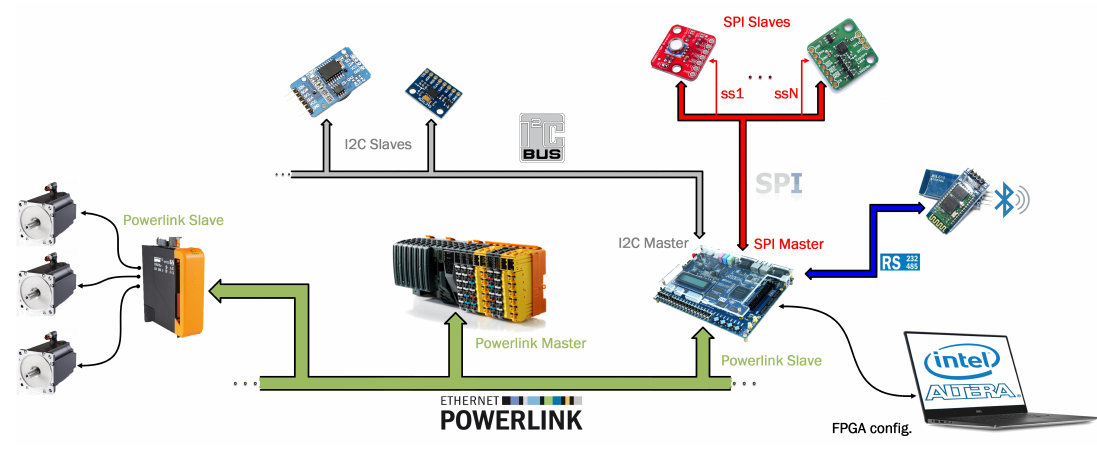
Figure 7. SPOF Use Case